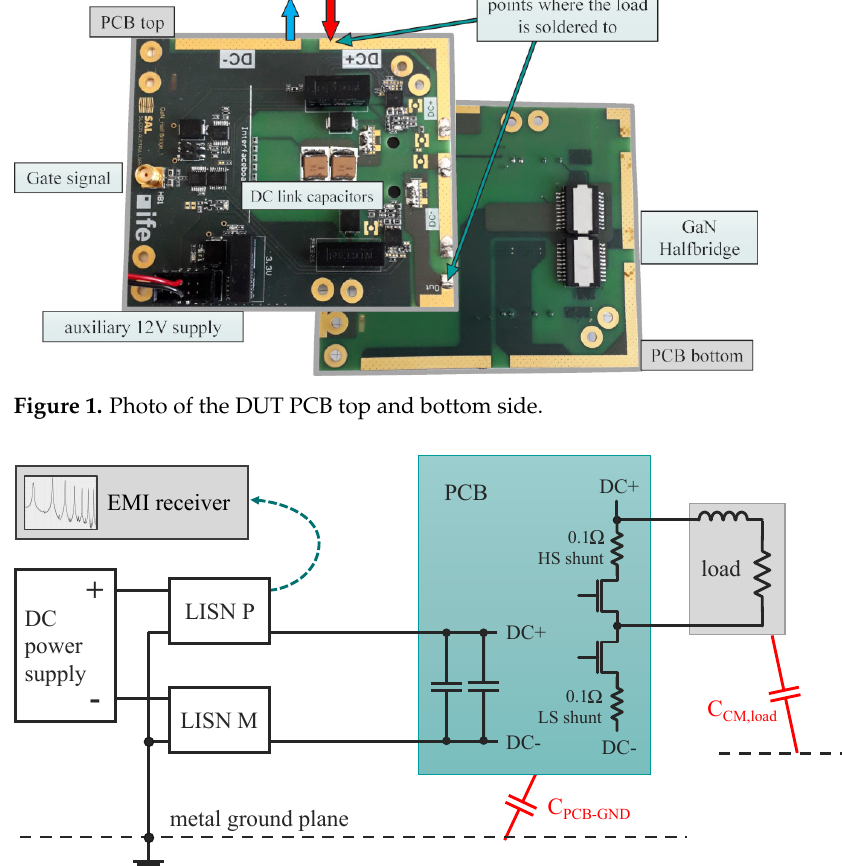
Figure 2. Schematic view of the conducted emission test setup. Parasitic coupling capacitances between PCB, load, and underlying GND plane are displayed in red. The EMI receiver is connected to the output of the positive supply LISN P. The unused output of LISN M is terminated by 50 Ω .